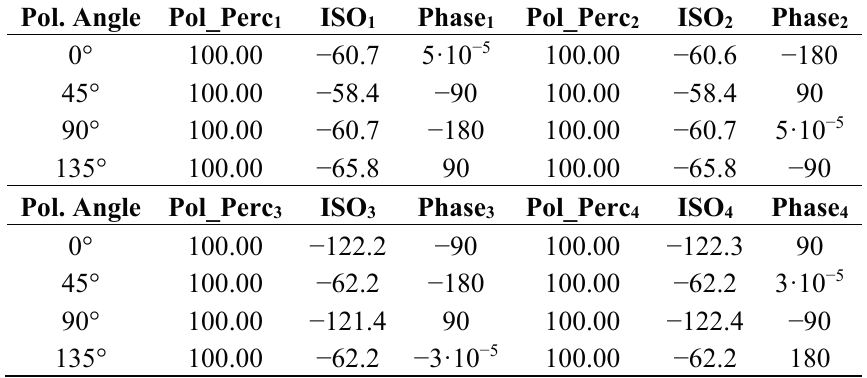
Table 6. Ideal parametric model simulation results using four excitation signals with polarization angles of 0°, 45°, 90°, and